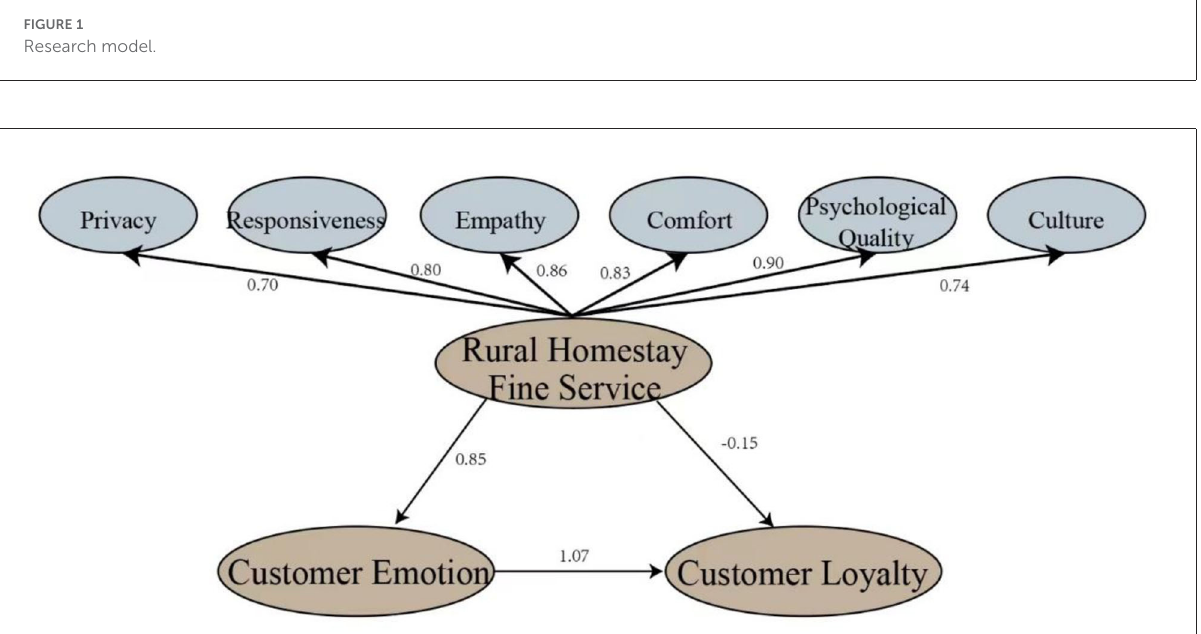
FIGURE2 Results of SEM